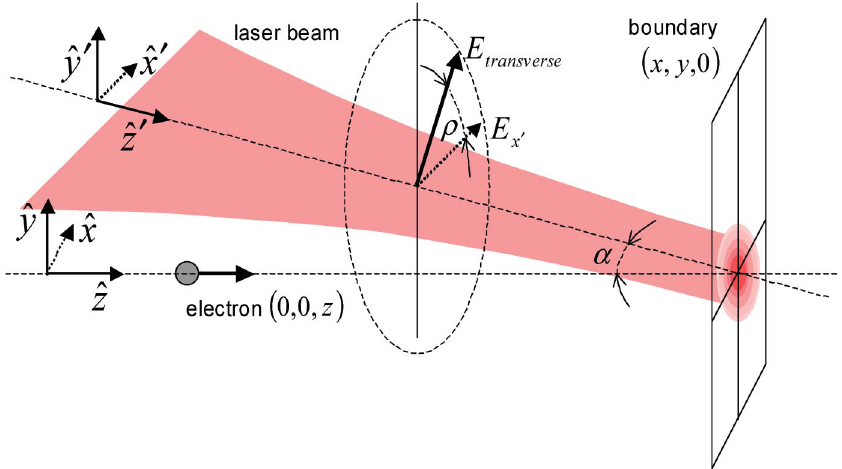
FIG. 1. (Color) Schematic diagram of the laser beam and the electron beam incident on a thin